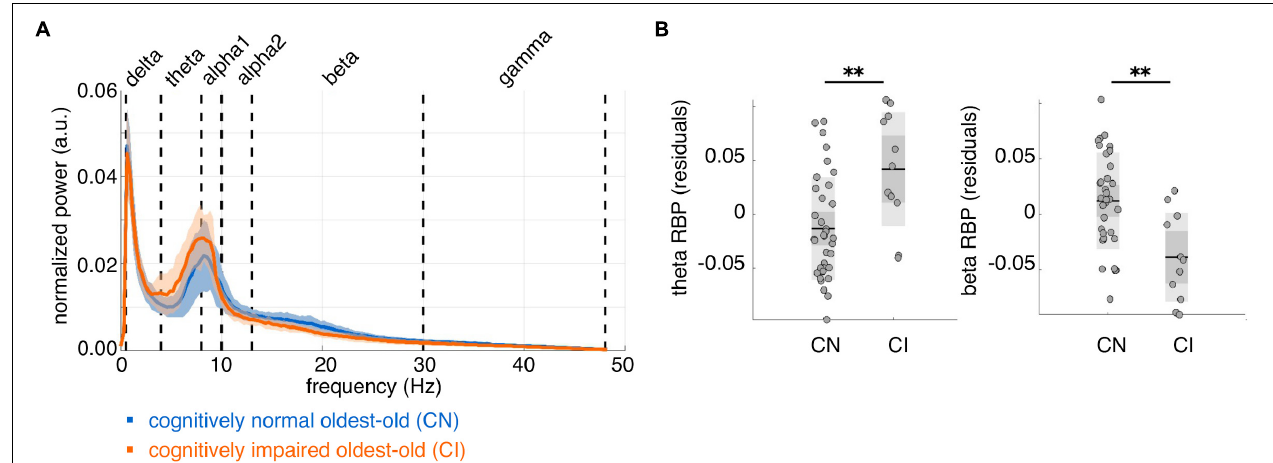
FIGURE 2 | Whole-brain average spectral properties of cognitively normal and impaired oldest-old subjects. (A) Group-average power spectral density curves over 80 cortical regions of interest, for cognitively normal ( n = 35, blue curve) and cognitively impaired ( n = 11, orange curve) subjects. Solid lines represent the group means; shaded areas represent ± 1 standard deviation interval. (B) Distributions of whole-brain relative band power (RBP) in the theta and beta band, after correction for age and gender. ∗∗ p < 0.001 for CI-CN comparison.